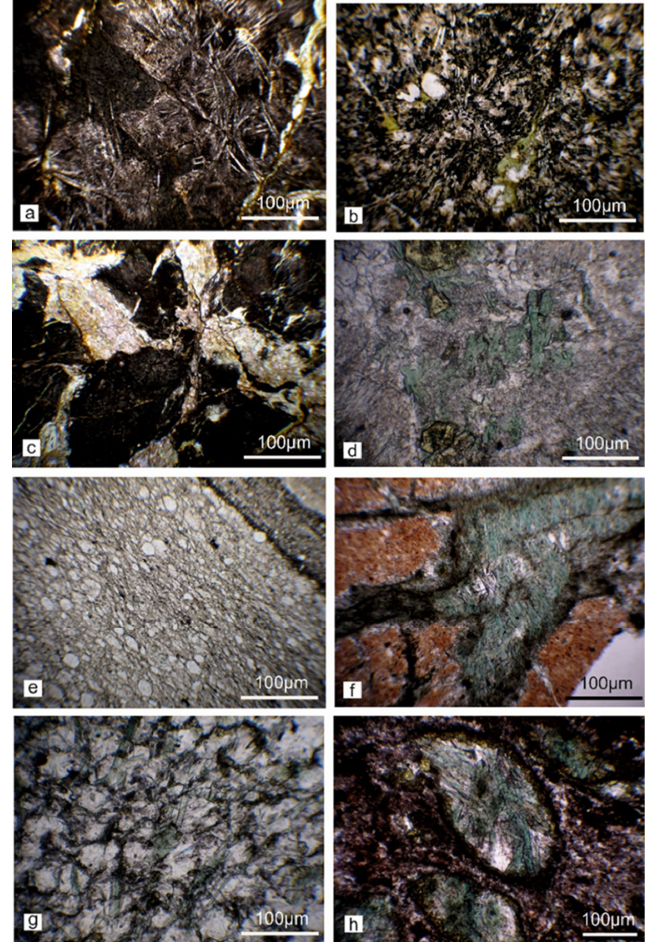
Figure 16. Microstructures of rocks from the Jaklovce–Ve ľ ký Folkmár area. ( a ) (s. JAK ‐ 1) and ( b ) (s. VFK ‐ 1) examples of well preserved magmatic–ophitic to acicular structures of N ‐ MORBs with Pl laths and tiny relics of Cpx crosscut by metamorphic veinlets. ( c ) Fragmented metabasalt by metamorphic veinlets. ( d ) Veinlet infill detail of s. JAK ‐ 1 with Cal, Act/Win/Rbk, Ep, Ab, and Chl. ( e ) Radiolarians ‐ bearing metacherts with Phg ‐ rich (original clayey) laminae (s. JAK ‐ 1/3). ( f ) Metamorphic veinlets crosscutting a metachert (s. JAK ‐ 1/2) composed of Amp (Act/Win/Rbk), Ep, Cal, ±Qz). ( g ) Granoblastic texture of a cherty carbonate enriched in metamorphic Amp aggregates. ( h ) Micro ‐ nodules in cherty clayey ‐ carbonatic shales (s. JAK ‐ 2/1) replaced by metamorphic Amp, Cal, and Ep.